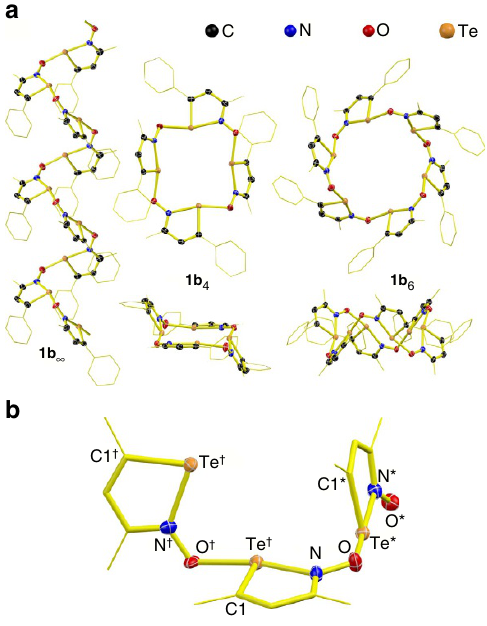
Figure 2 | Crystallographically characterized aggregates of 1b. ( a ) ORTEPs of the aggregates observed in the crystal structures of 3-methyl-5-phenyl-isotellurazole- N -oxide, 1b . While 1b N is contained in 3( 1b ) (cid:3) (C 6 H 6 ), the macrocyclic tetramer crystallizes in a solvent-free polymorph and the hexamer forms the co-crystal 12( 1b ) (cid:3) (CH 2 Cl 2 ). ( b ) Detail of the structure of 1b N displaying the relative orientations of the iso-tellurazole planes and the labelling sequence used in the discussion. Displacement ellipsoids are plotted at 75% probability in all cases. For clarity, hydrogen atoms are omitted, the phenyl and methyl groups are portrayed using a wireframe representation and are partially hidden in b .